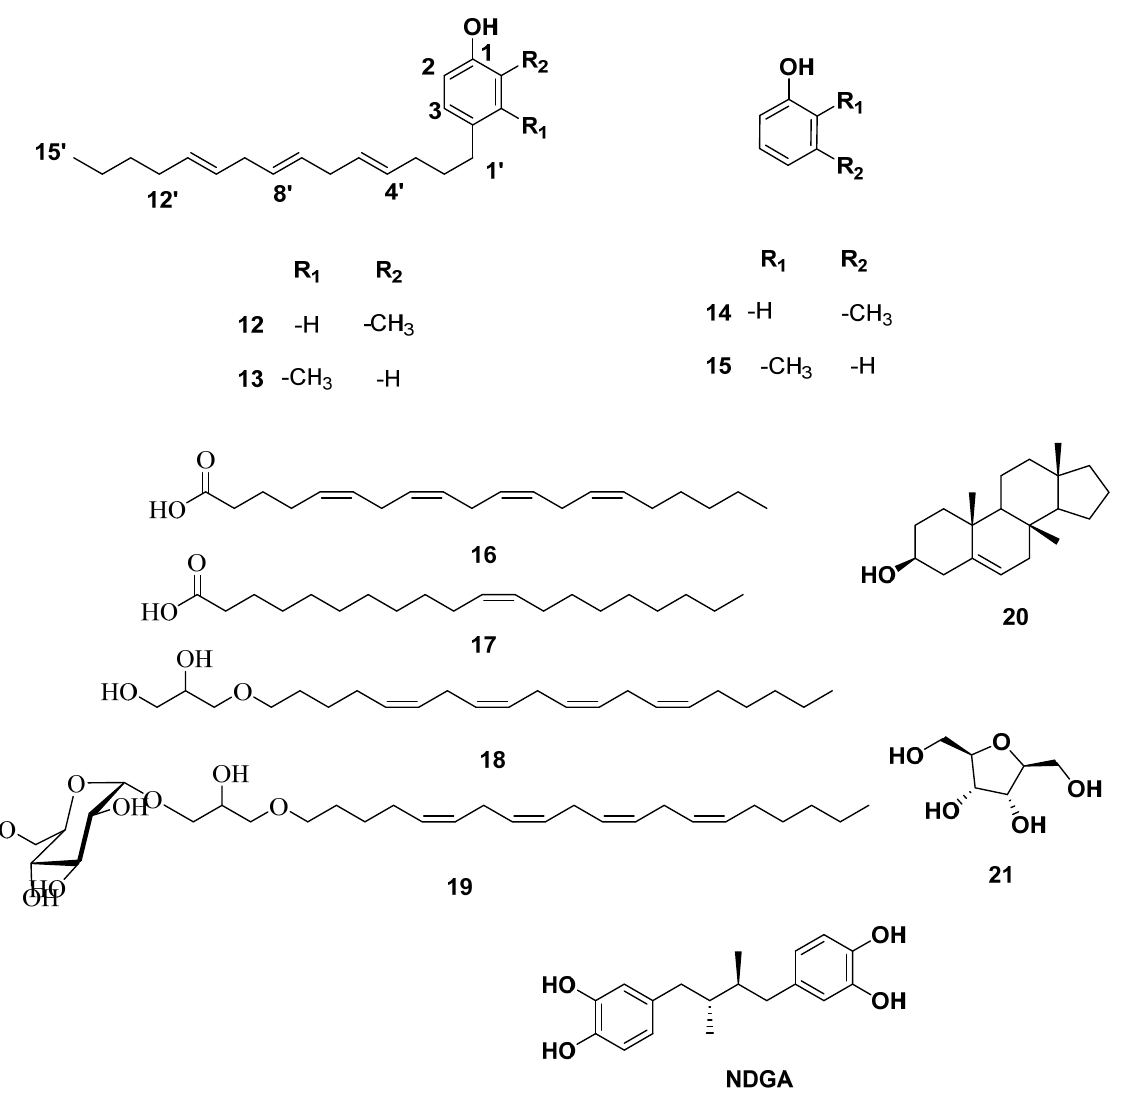
Figure 2. Structures of compounds isolated from S. cinereum 12 – 21 together with 5-lipoxygenase (5-LOX) and 15-LOX’s co-crystallized ligands AA 16 and nordihydroguaiaretic acid